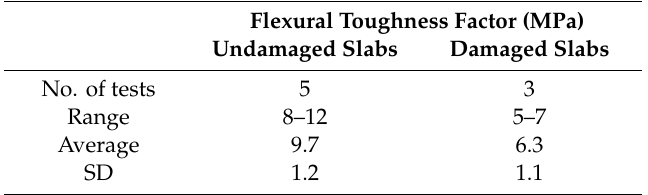
Table 11. Flexural toughness factor average value and standard